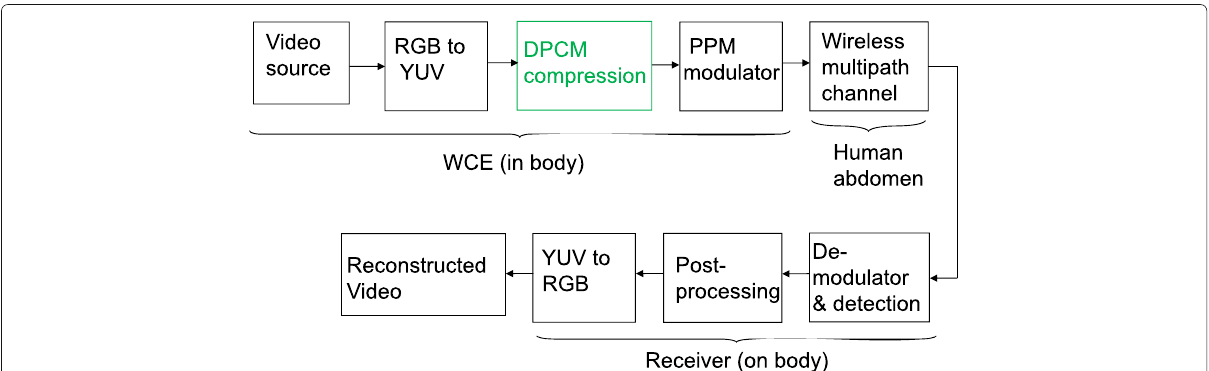
Fig. 1 WCE communication system. The compression stage (green block) will be excluded in many examples